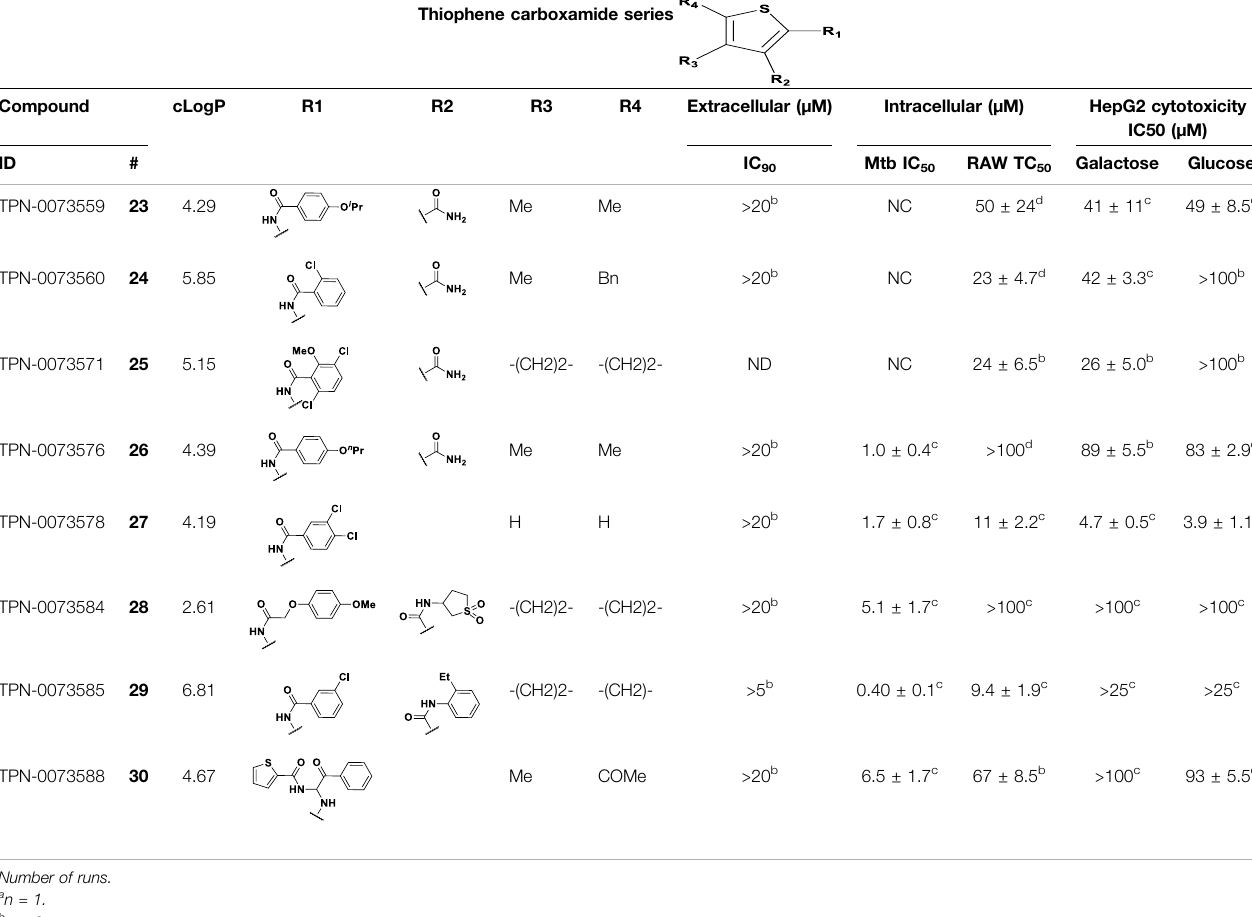
TABLE 7 | Catalog structure-activity relationship of the TPC series.